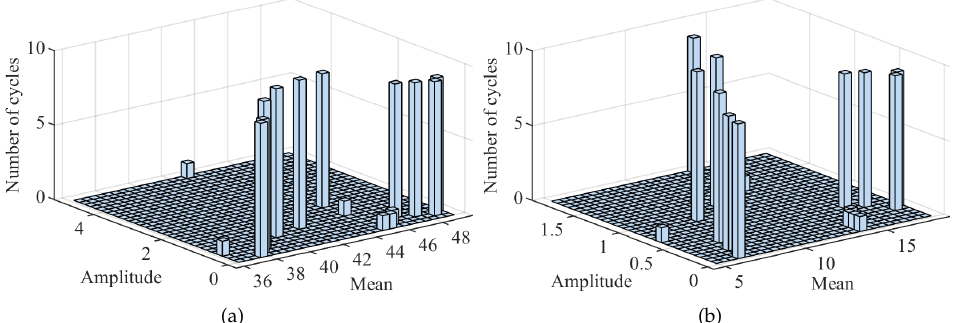
Figure 17. Results from rainflow cycle counter of the maximum TMS of stator insulation. ( a ) Normal pressure. ( b ) Deep-sea pressure 20